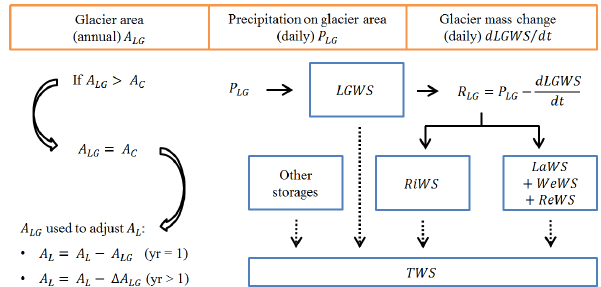
Figure 1. Schematic of integration of glacier data from the global glacier model (GGM) into WaterGAP at grid cell scale. Glacier data sets are represented by orange boxes. Blue boxes represent water storage compartments in WaterGAP (for definitions of the abbrevi- ations, refer to Eq. 2). Full arrows represent water flows, and dotted arrows indicate that the sum of changes in individual storages equals total water storage change. See text for details and